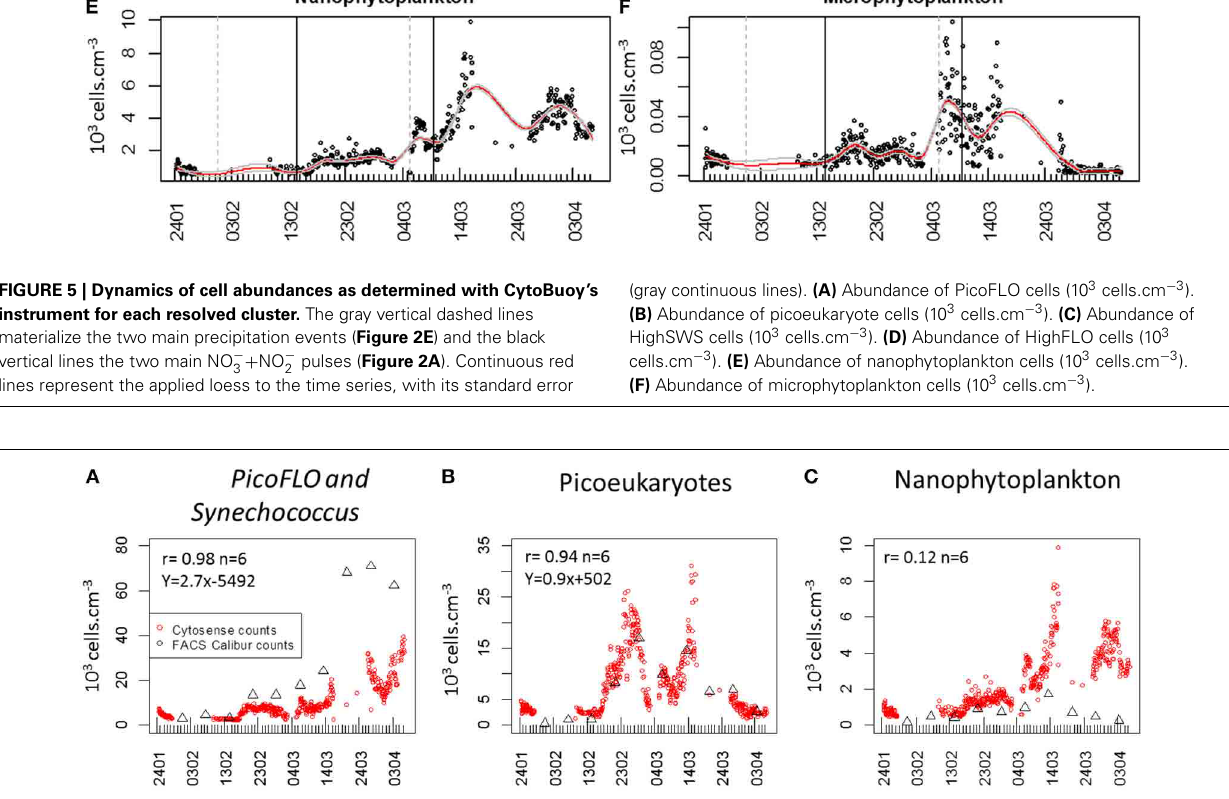
counts is given in each panel. (A) PicoFLO cells (10 3 cells.cm − 3 ). (B) Picoeukaryote cells (10 3 cells.cm − 3 ). (C) nanophytoplankton cells (10 3 cells.cm − 3 ).